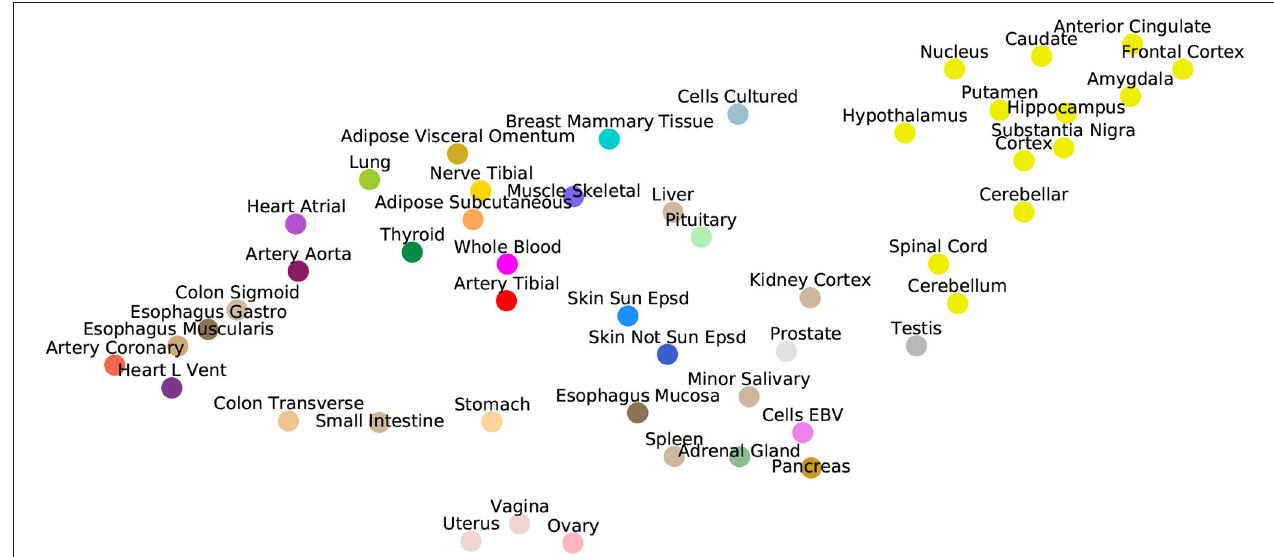
FIGURE 3 | UMAP visualization of the tissue embeddings from the generator. Colors are assigned to conform to the GTEx Consortium conventions. Note that the central nervous system, consisting of the 13 brain regions, clusters together on the top right corner.